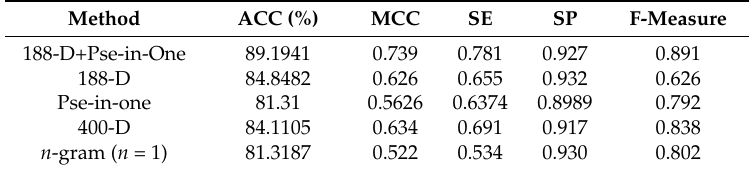
Table 1. The result of using different feature representation methods on cross-validation.